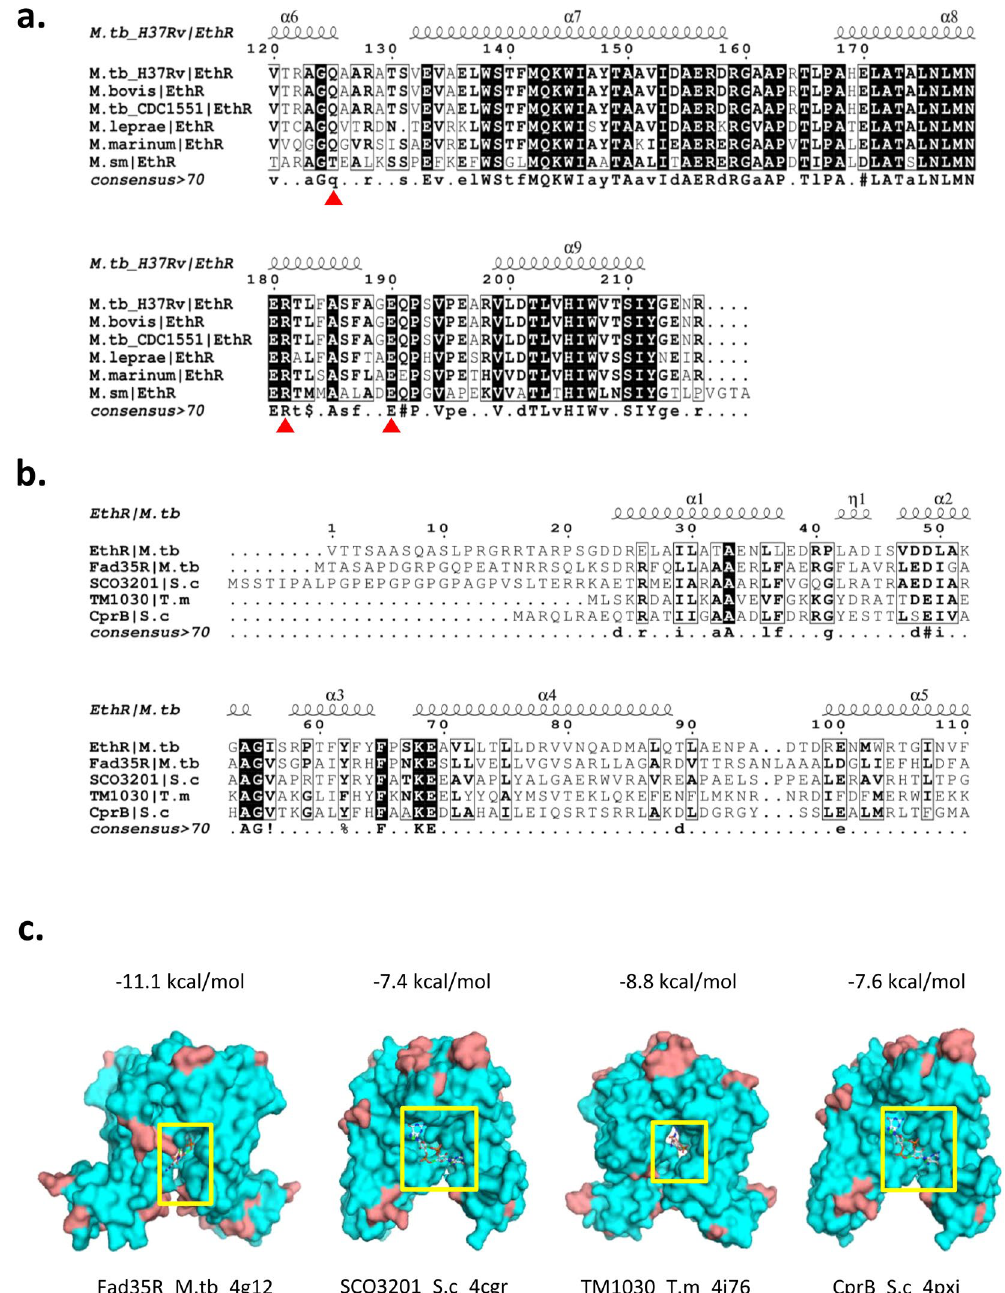
Figure 5. Mechanism of the binding of c-di-GMP to Ethr is general. ( a ). Sequence alignment and secondary structure element of Ethr in mycobacteria. Secondary structure element is showed above sequences. Sequence similarities are highlighted by black background (identities) and boxes (similarity). Red star represents conservative sites of Ethr with the binding of c-di-GMP at Q125, R181, E190. M.tb _H37Rv = Mycobacterium tuberculosis H37Rv, M.bovis = Mycobacterium bovis , M.tb _CDC1551 = Mycobacterium tuberculosii CDC1551, M.leprae = Mycobacterium leprae , M.marinum = Mycobacterium marinum , M.sm = Mycobacterium smegmatis . ( b ). Sequence alignment and secondary structure elements of TetR like protein in many strains. Sequence similarities are highlighted by black background (identities) and boxes (similarity). Helix α 1, α 2, and α 3 with a higher conservation represent the DNA binding domain. M.tb = Mycobacterium tuberculosis , S.c = Streptomyces coelicolor , T.m = Thermotoga maritima . ( c ). Docking model of the four TetR like proteins with c-di-GMP. The affinity is showed above the model. Yellow boxes represent the pockets of protein that c-di-GMP binds